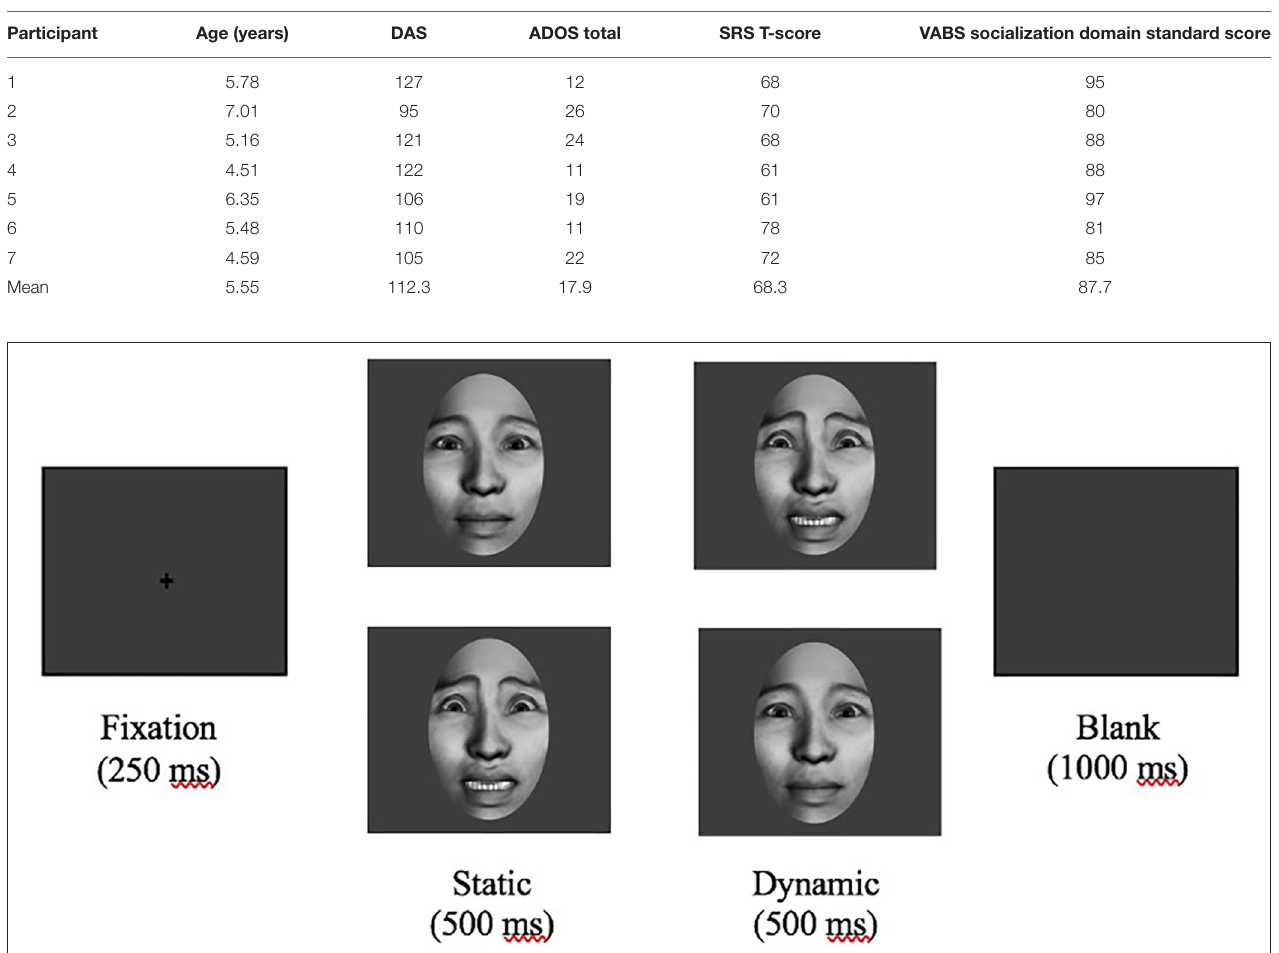
FIGURE 1 | Experimental paradigm. After a 200–300ms fixation crosshair, a static neutral or fearful face was presented for 500ms before dynamically changing expression. ERP data was segmented to an epoch 100ms before to 500ms after presentation of the initial static face.